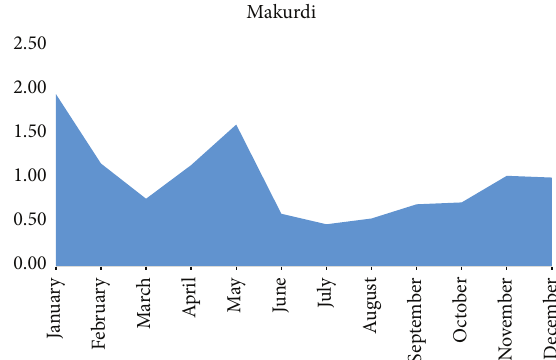
Figure 1: Monthly average prevalence of tuberculosis lesions in cattle slaughtered in Makurdi from 2008 to